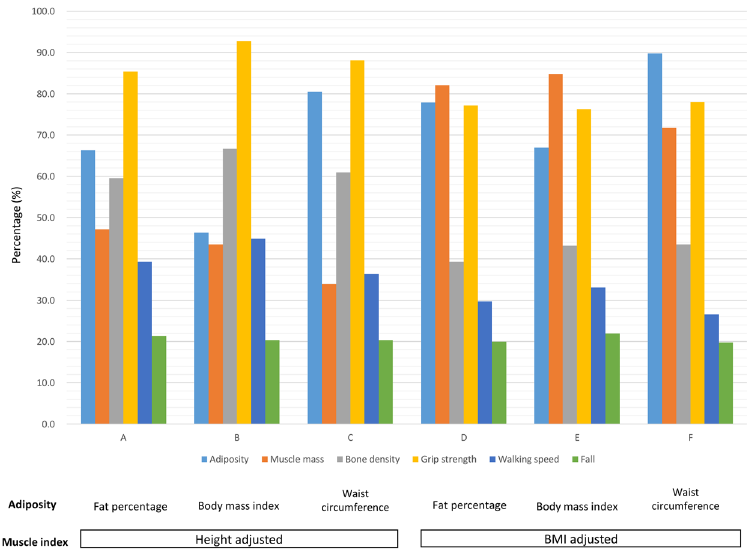
Figure 3. Distributions of dysmobility conditions by six different definitions of dysmobility